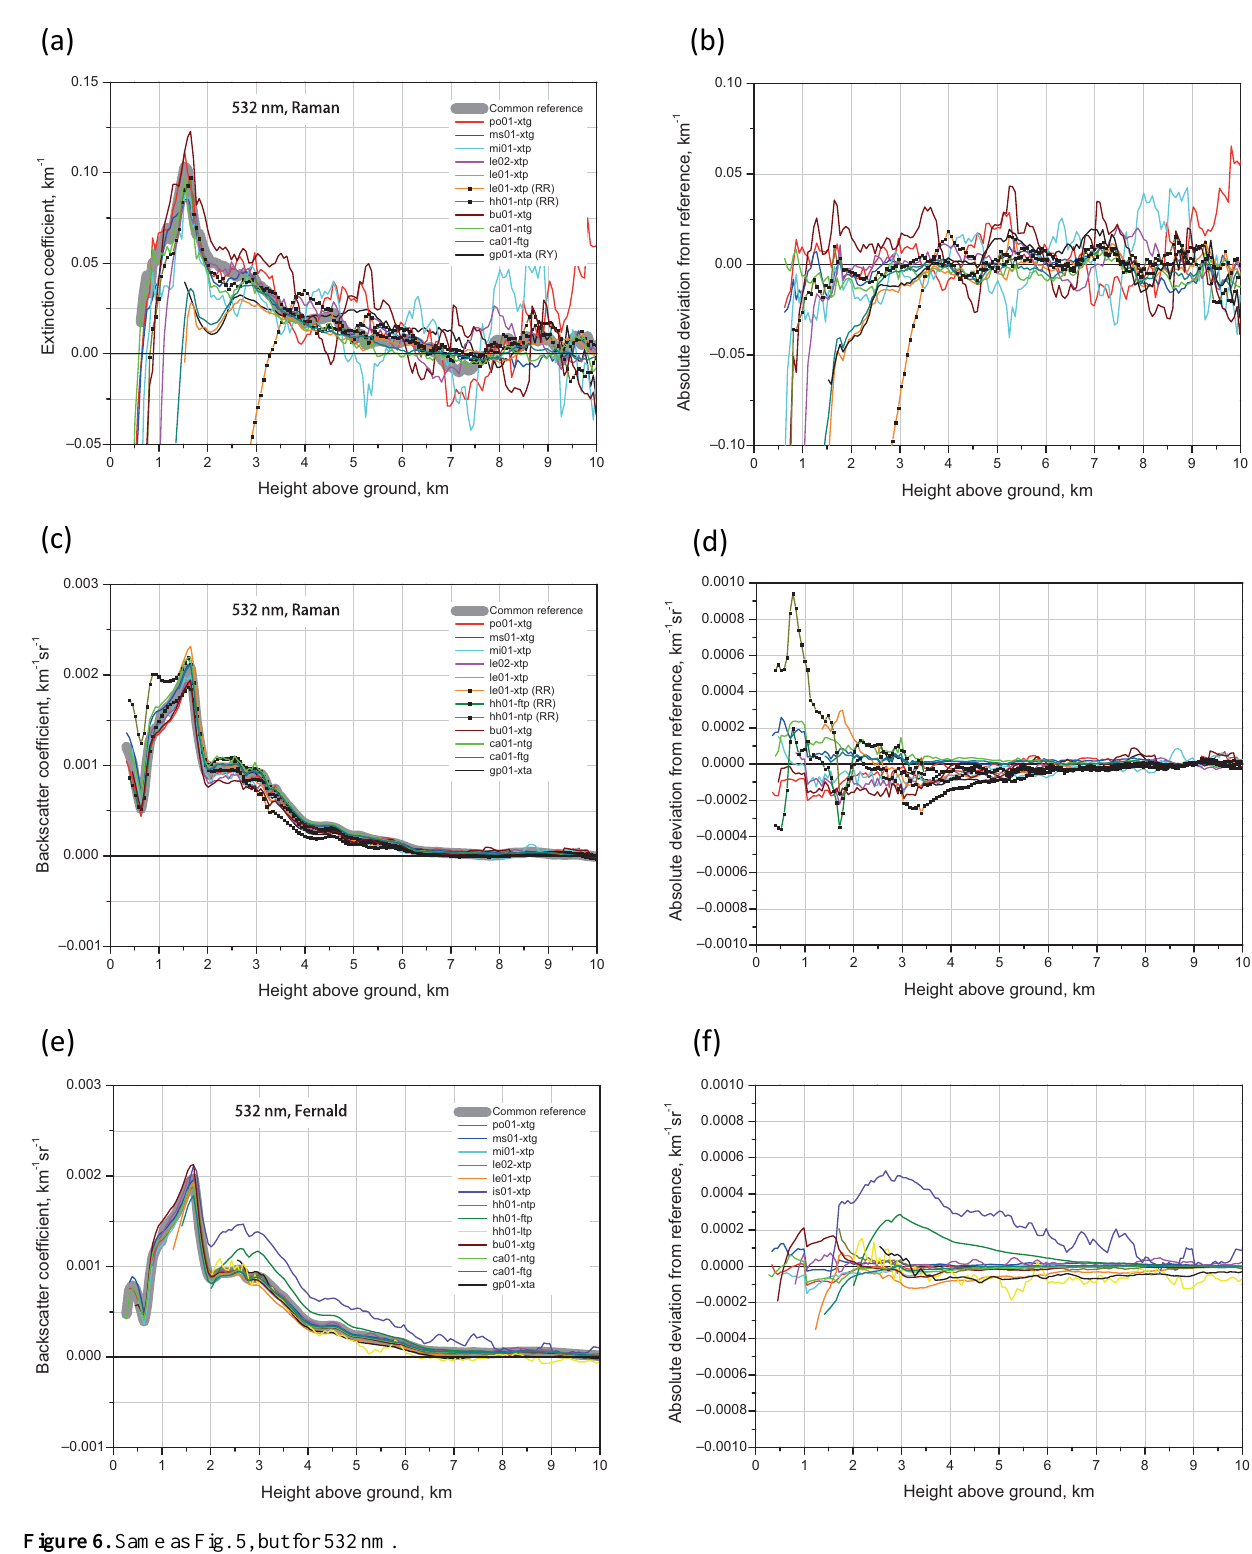
Figure 6. Same as Fig. 5, but for